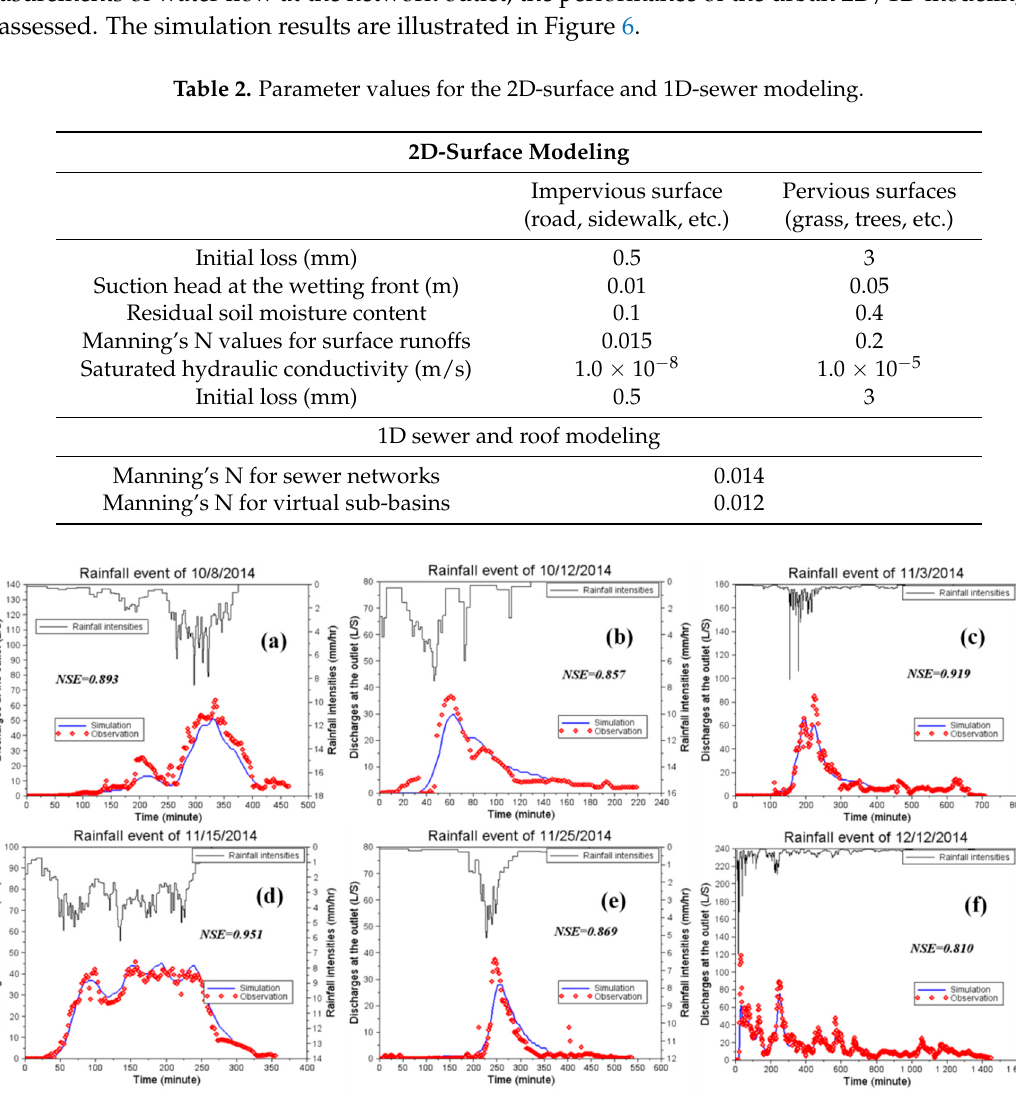
Figure 6. Water flow simulations using the urban 2D/1D TRENOE model with the DTM + LiDAR topography and detailed land-use data. The simulated discharges at the network outlet (solid blue lines) are compared with the measured data (red circles). Rainfall is plotted on the upper part. For